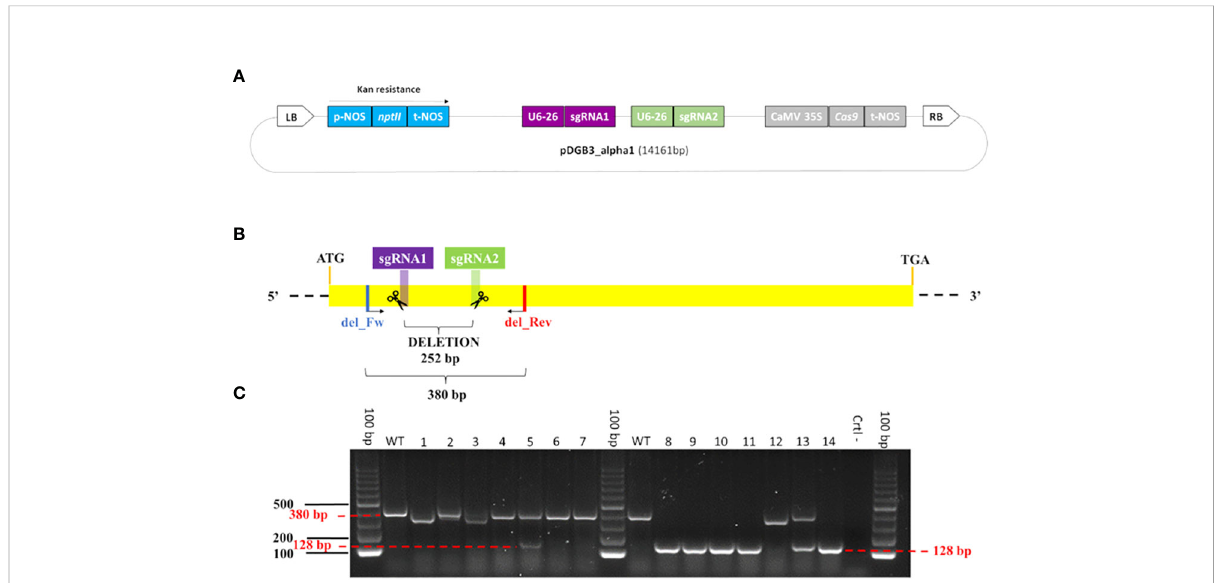
FIGURE 1 Genome editing construct for the b -LCY2 gene and validation of edited plantlets. (A) Map (not at scale) of the fi nal vector p-DGB3_alpha1 (14.161 bp). From the left border (LB) to the right border (RB), the main portions of the construct are: the neomycin phosphotransferase II gene ( nptII , light blue) with the NOS promoter (p-NOS) and terminator (t-NOS); the two sgRNAs (purple and green) each with the U6-26 promoter; the Cas9 gene (silver) with the CaMV 35S promoter and NOS terminator. (B) Schema of sgRNAs into b -LCY2 . The size of the deletion between the sgRNAs is 252 bp; the length of the amplicon using the del_Fw and del_Rev primers is 380 bp. (C) Gel electrophoresis showing the PCR products of edited plantlets. Samples #4, #6, #7, and #12 show pro fi le I, in which one or both sgRNAs are putatively edited; samples #8, #9, #10, #11, and #14 show pro fi le II, consisting of a large deletion of 252 bp, with an amplicon of 128 bp; samples #5 and #13 show pro fi le III, consisting of two amplicons of 380 bp and 128 bp; samples #1, #2, and #3 show amplicons whose lengths are a little bit different than expected, due to a diverse editing event, and described as pro fi le IV; 100 bp is the ladder; WT is the wild type; Ctrl- is the negative